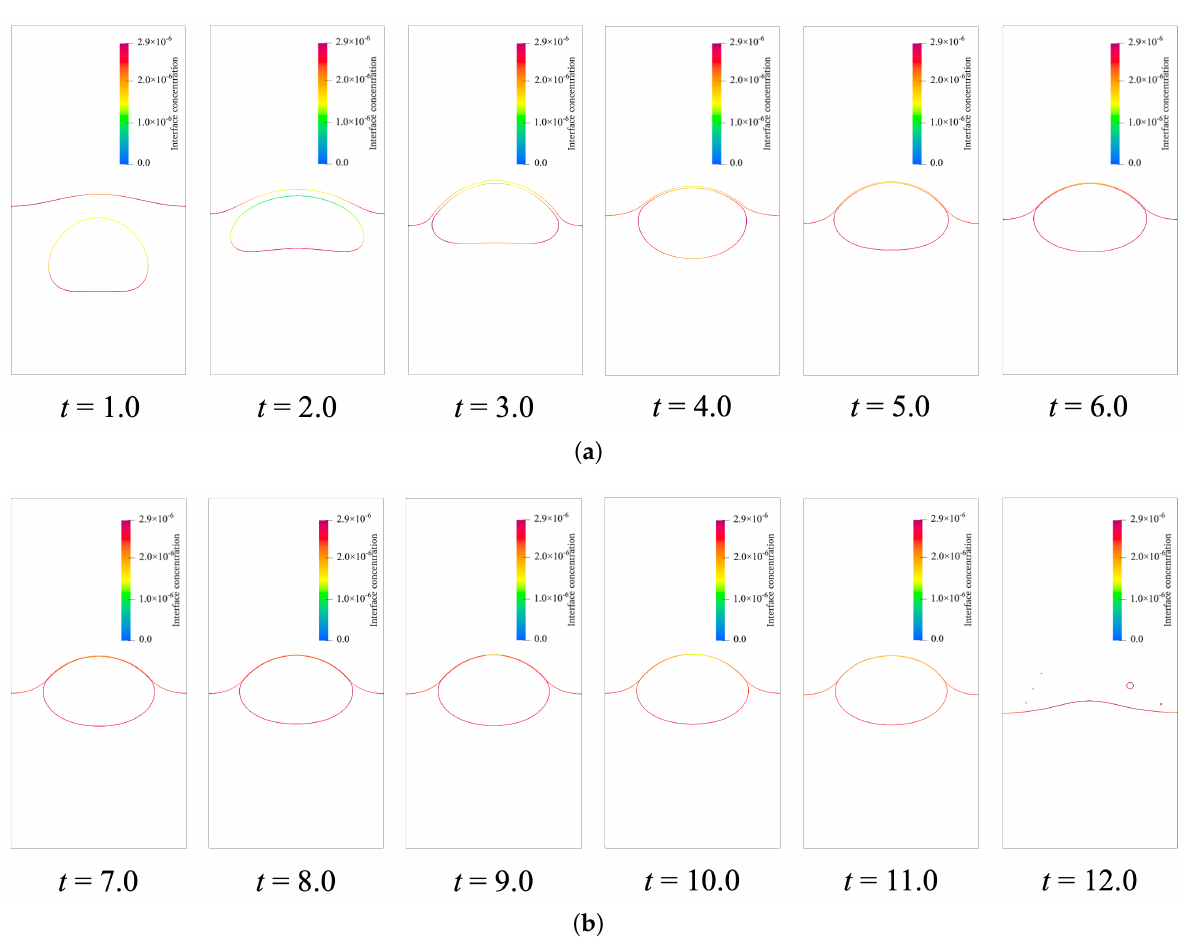
Figure 17. Interface concentration profile for the bubble rising to an interface starting from the contaminated state and forming liquid film in surfactant solution, La = 15, from t = 1.0 to t = 12.0. The color legend ranges from f = 0 to a saturation concentration of f = 2.9 × 10 − 6 . ( a ) Interface concentration profile for the bubble rising to an interface starting from the contaminated state and forming liquid film in the surfactant solution, La = 15, from t = 1.0 to t = 6.0. ( b ) Interface concentration profile for the bubble rising to an interface starting from the contaminated state and forming liquid film in surfactant solution, La = 15, from t = 7.0 to t =